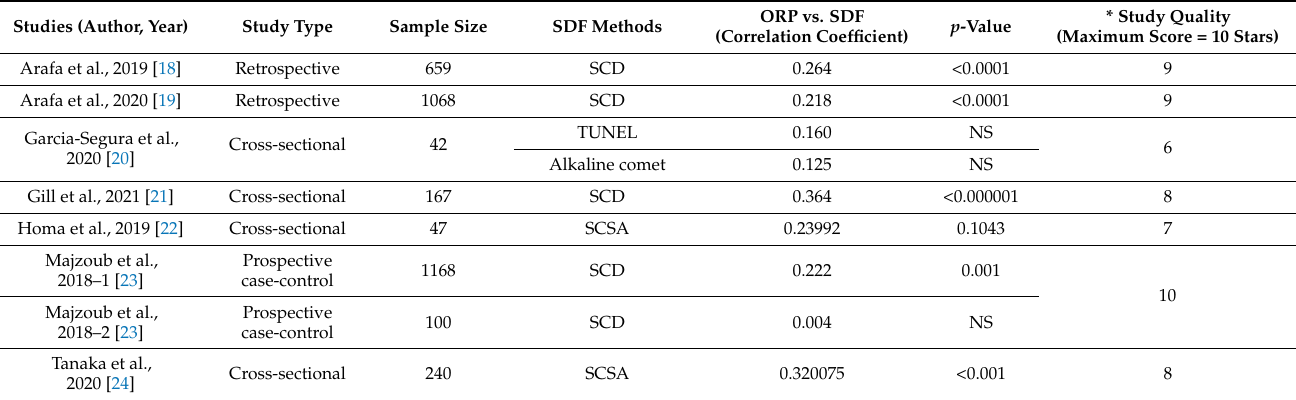
Table 1. Details of the original studies evaluated both ORP and SDF in semen